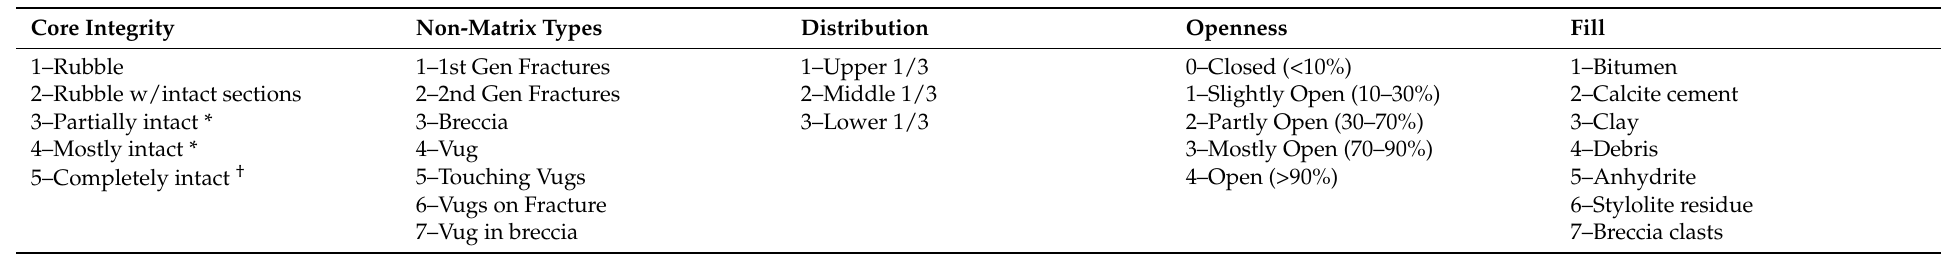
Figure 2. Example of a spreadsheet format used in the NMQP methodology. A detailed explanation of the non-matrix metrics that are recorded is provided in the text. Table 1. Example key of the alphanumerical system used in the NMQP